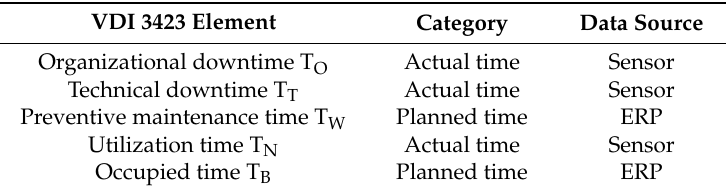
Table 7. Elements of VDI 3423 calculation.